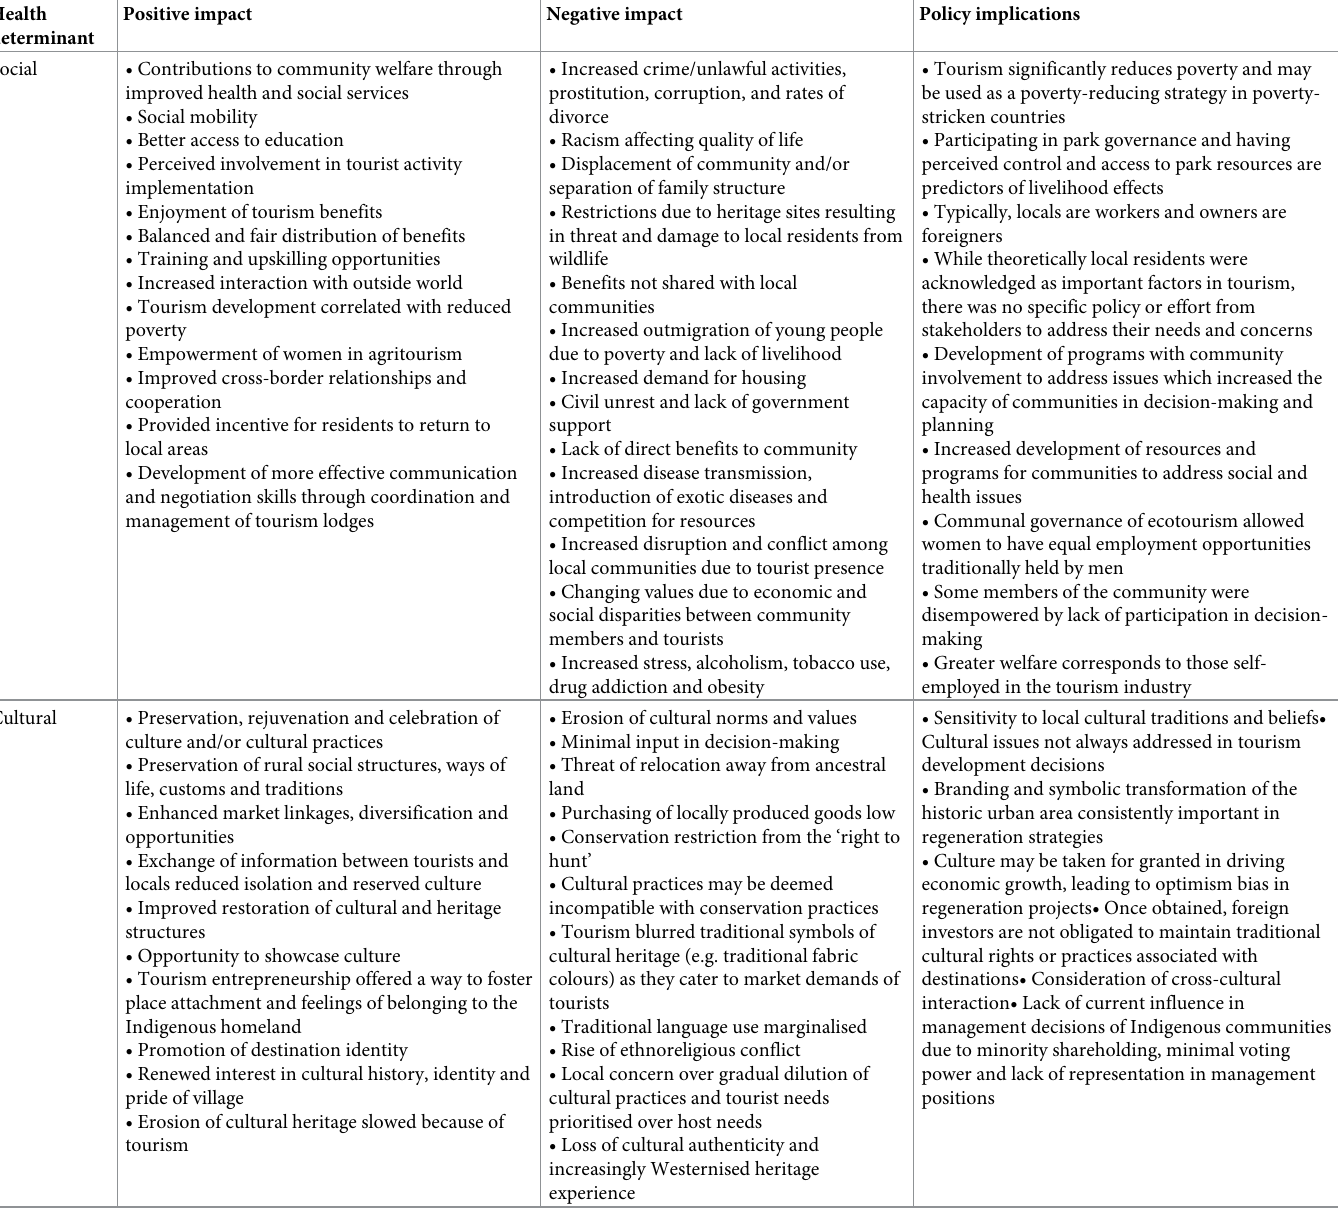
Table 2. Major themes identified from translation and synthesis of included